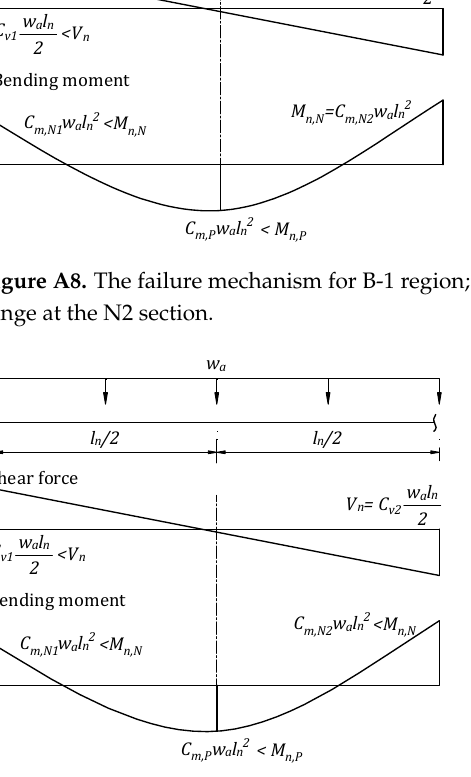
Figure A9. The failure mechanism for B-2 region; shear failure at N2 section without forming any plastic hinge.